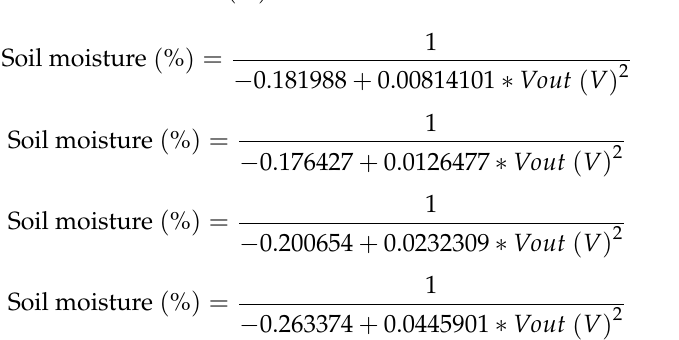
Figure 25. The Vout in the different frequencies tested in prototype NP2.